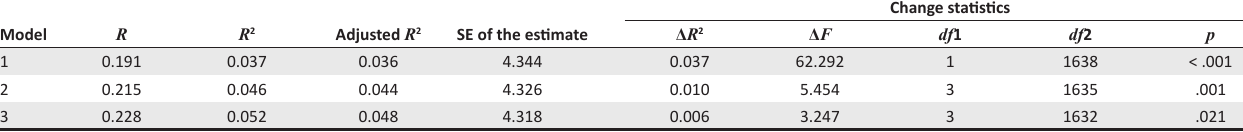
TABLE 2: Hierarchical moderated multiple regression of the relations between OPP Social Conformity Scale, cognitive ability, and language/culture. Model